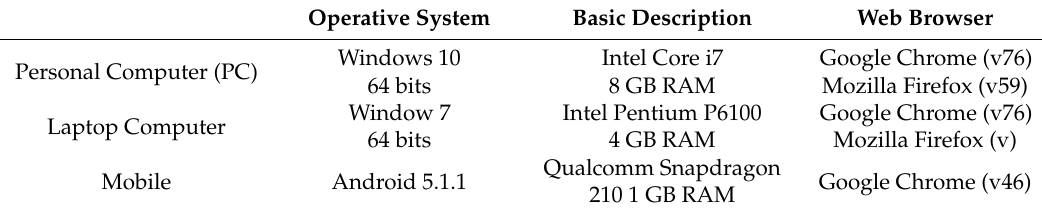
Table 5. Setup for clients running ECGView application.